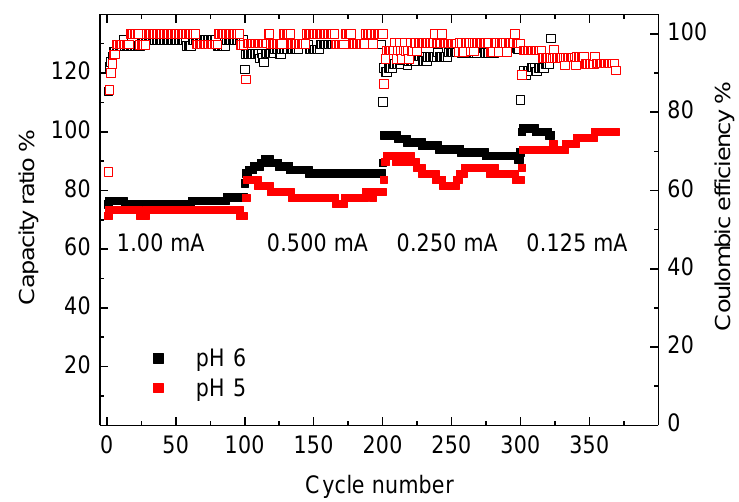
14 of 16 Figure A6. Cyclic voltammetry of different electrolyte solutions at 20 mV/s. Appendix A.6. Electrochemical Tests of AC Electrodes Prepared in Different Conditions With the same procedure used for the preparation of NTP and LFP electrodes, we also prepared AC electrodes (85:10:5 w/w ) with the addition of the EDC solution on the electrode disks, by decreasing the crosslinking time to 4 h. We used two different EDC solutions: one without modifying the pH (ca. 6.0) and the other by decreasing the pH to 5 for a faster reaction of EDC. The electrochemical stability of AC electrodes in 1.5 M Na 2 SO 4 solution is reported in Figure A7. Coulombic efficiency values decreased at lower currents